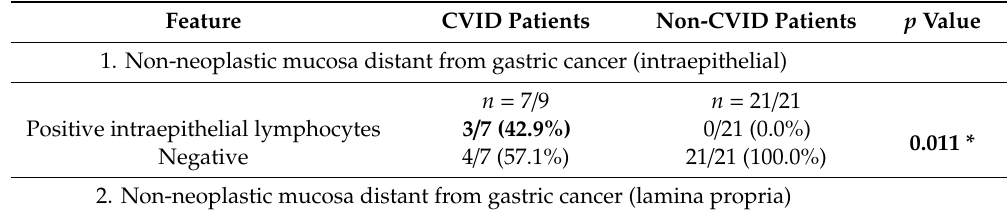
Table 3. PD-L1 expression in non-neoplastic mucosa (“distant from” and “adjacent to” tumour) and adenocarcinomas of CVID patients in comparison with non-CVID